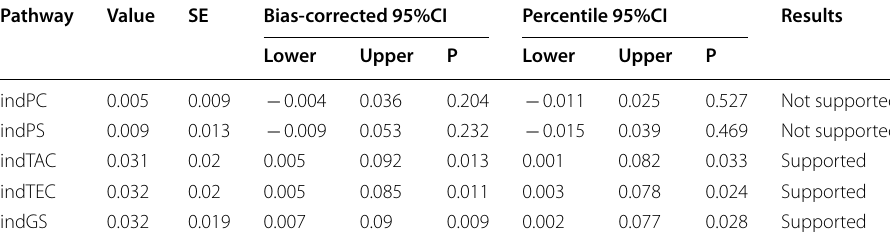
Table 9 Unstandardized Bootstrap mediation effect